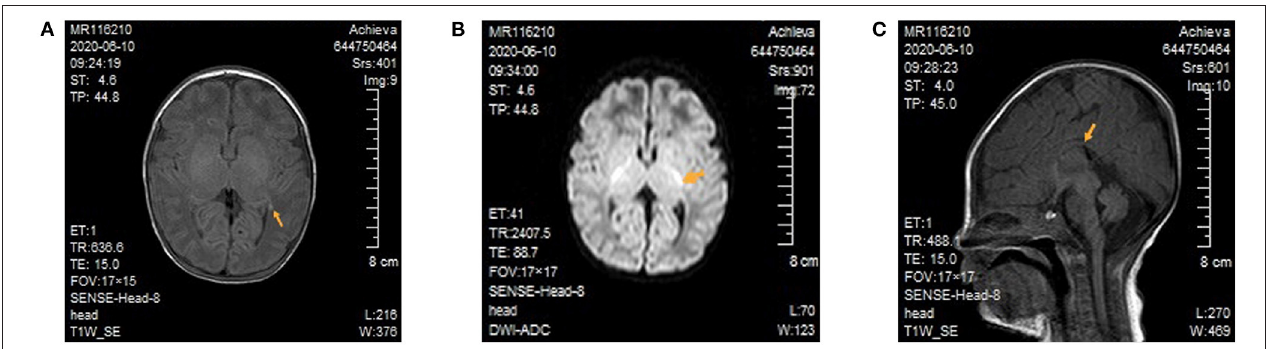
FIGURE 1 | Cranial magnetic resonance imaging of the patient. (A) Focal cerebral hemorrhage of the left paraventricular brain. There was no high T1 signal in the posterior limb of bilateral internal capsule. (B) In the diffusion-weighted image, high signals can be seen for the posterior limb of the internal capsule. (C) The thin and short of corpus callosum.